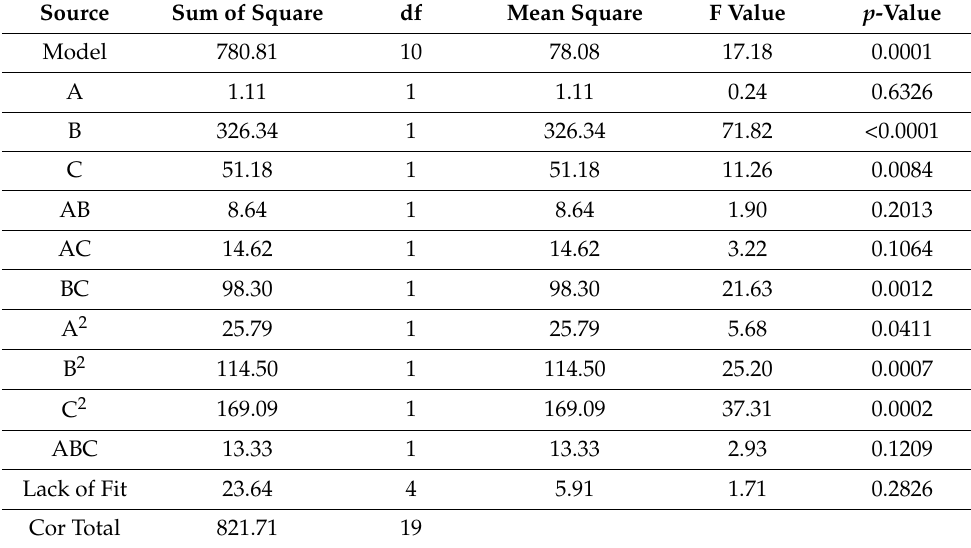
Table 6. ANOVA and significant analysis for central composite design.